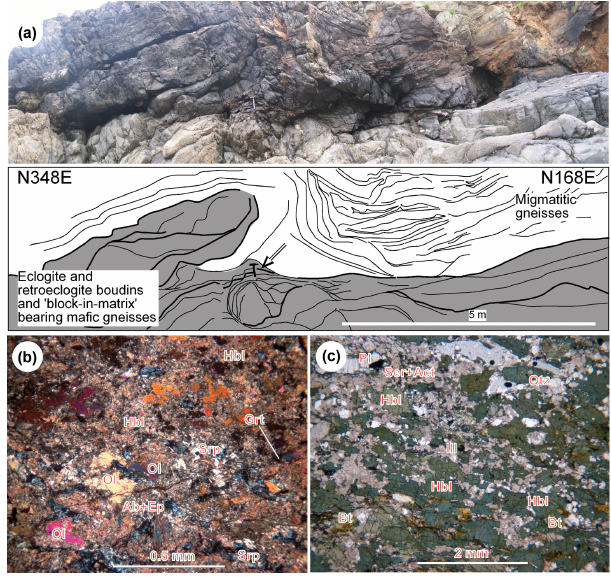
Figure 3. Mafic gneisses and related rocks. (a) Structures at the exposure scale; the sketch shows the attitude of the main S 2 folia- tion at the contact between mafic gneisses and migmatitic gneisses. Microphotographs: (b) retrogressed coronitic metagabbro (sample B917); (c) Bt-Grt-bearing amphibolite gneisses within the less de- formed lozenges (sample B714). Sample location is indicated in Fig.